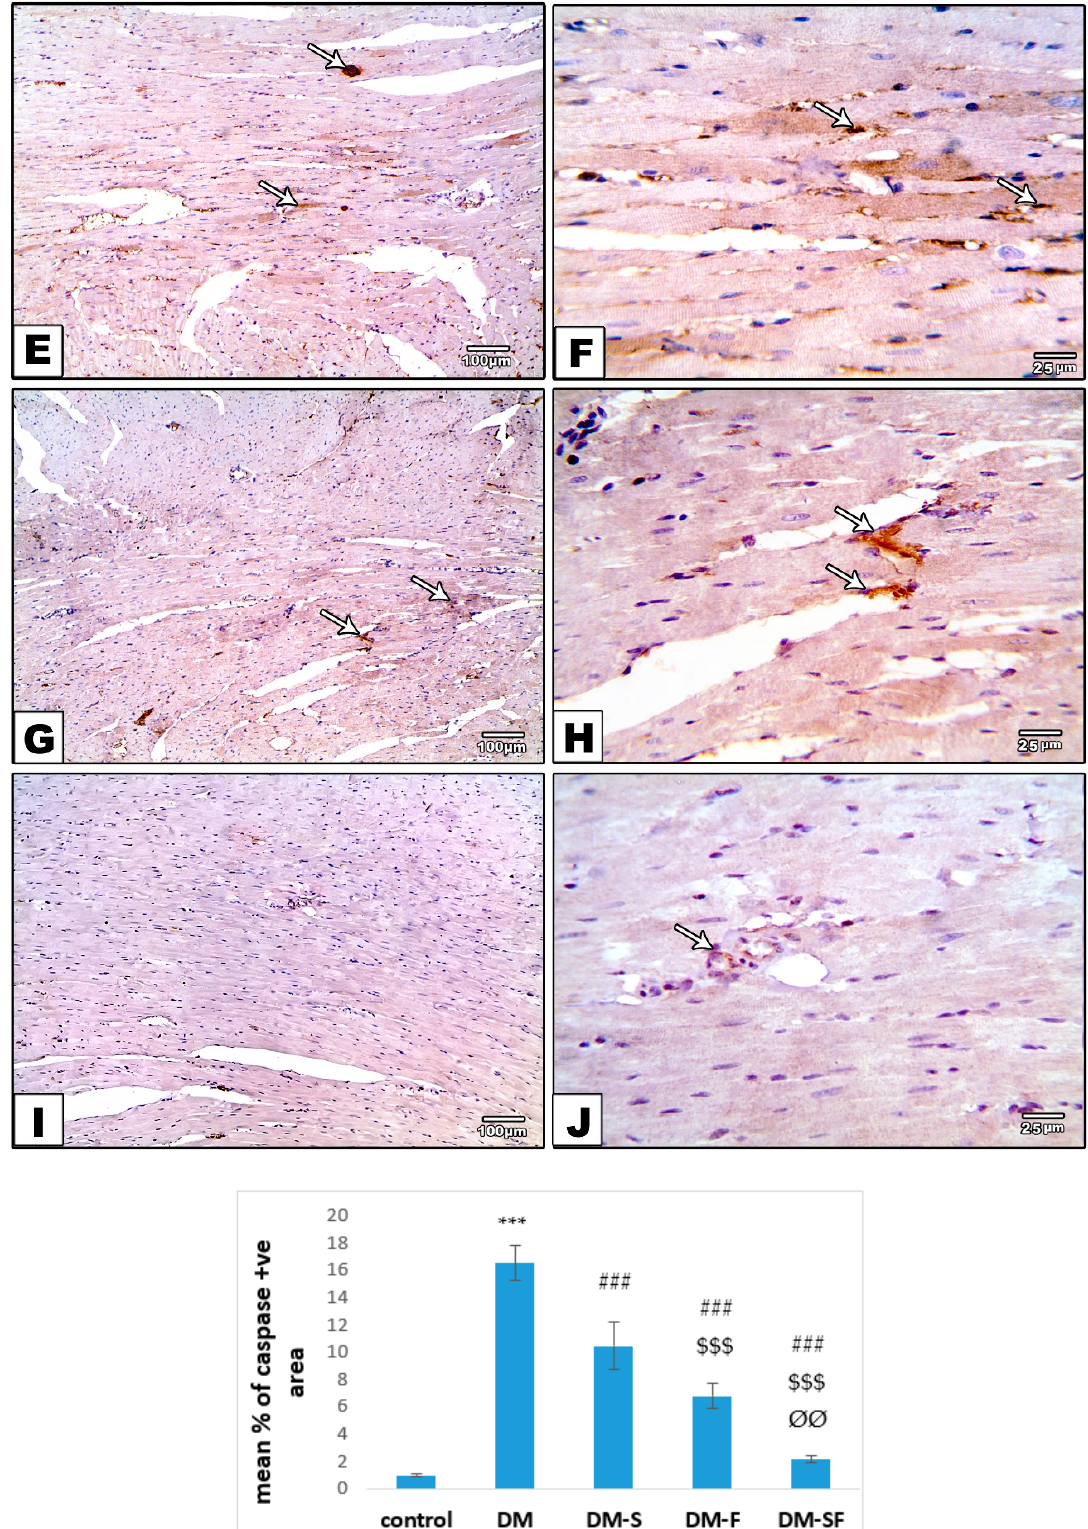
Figure 5. ( A – J ) show caspase-3 immunohistochemical staining in different groups. ( A , B ) negative cytoplasmic expression of caspase-3 in cardiomyocytes in the control group, ( C , D ) significant